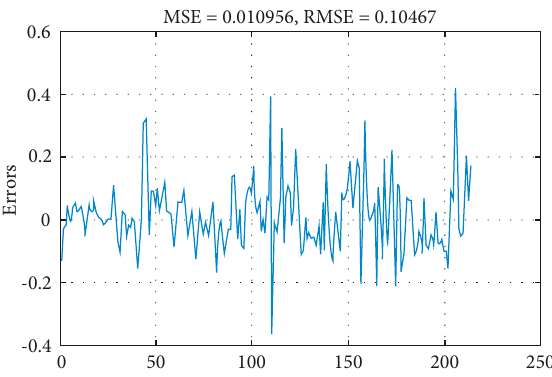
Figure 6: MSE and RMSE for all data set merge.